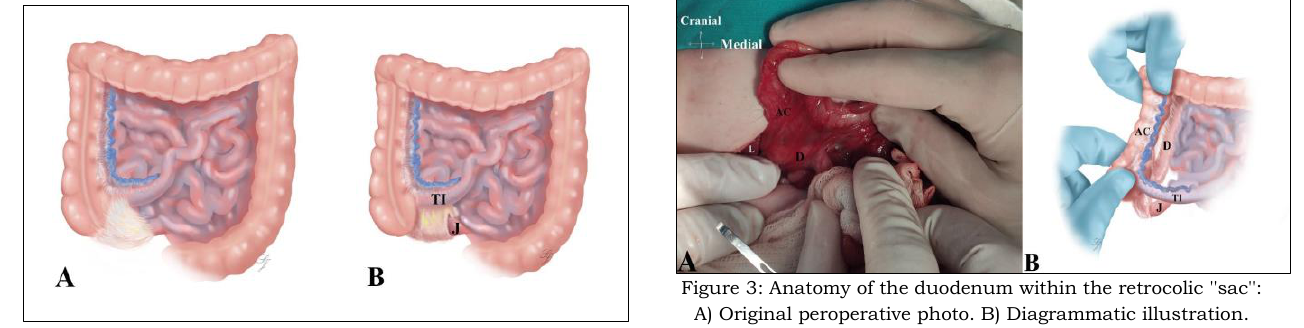
Figure 1: Diagrammatic illustration: A) Intestinal anatomy at first glance. B) Intestinal anatomy after releasing the ileocecal